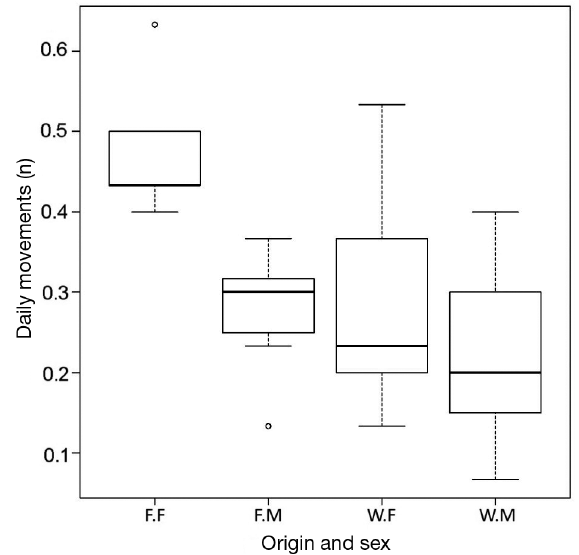
Fig. 8. Observed number of daily movements of Atlantic salmon Salmo salar as a function of origin and sex. The bot- tom and top of the box delineate the 25 th and 75 th percentiles (i.e. the boxes include the middle 50% of the observations). The whiskers span to the most extreme data point, which is no more than 1.5 times the interquartile rage, and the bold horizontal line represents the median value. W.F: wild females (n = 11); W.F: wild males (n = 8); F.F: farmed females (n = 5); F.M: farmed males (n = 7). Individuals of unknown